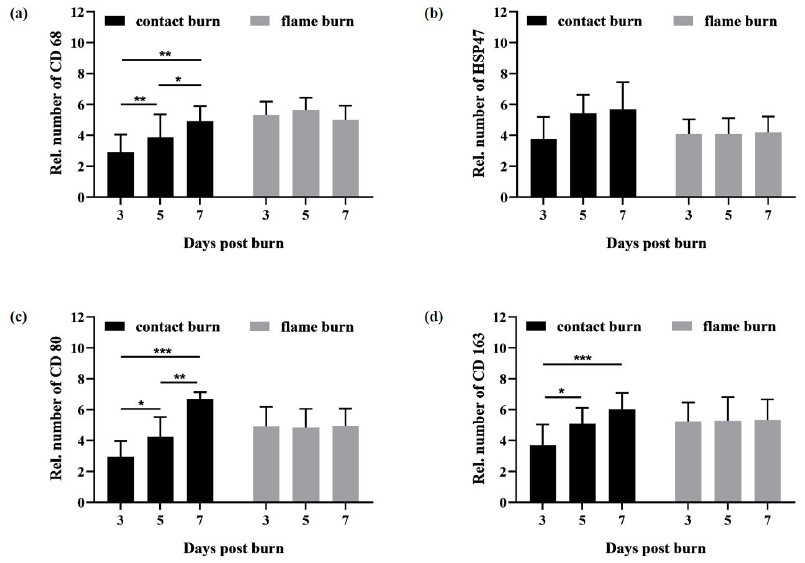
Figure 4. Number spatiotemporal increase in the number of macrophages and fibroblasts in response to contact and flame burns. Composite tissue samples from 6 different donors were subjected to contact (contact burn) or flame burns (flame burn). Samples were maintained in vitro for three (day 3), five (day 5), or seven days (day 7) after injury. Later, tissue sections were subjected to immunohistochemistry and DAB staining using antibodies against CD68, HSP47, CD80 or CD163. The number of positive cells was determined in at least 5 equivalent microscopic fields in different locations within the burn-damaged and undamaged zones of subcutaneous tissue. To calculate the relative number of cells, the mean number of positive cells in the unharmed zone was set to 1 and was compared to the number of positive cells in the burn-damaged zone. The diagrams summarize the mean relative numbers of positive cells expressing CD68 ( a ), HSP47 ( b ), CD80 ( c ) or CD163 ( d ). The error bars indicate the standard deviation (SD). Statistical significance is shown with * p ≤ 0.05, ** p ≤ 0.01 or *** p ≤